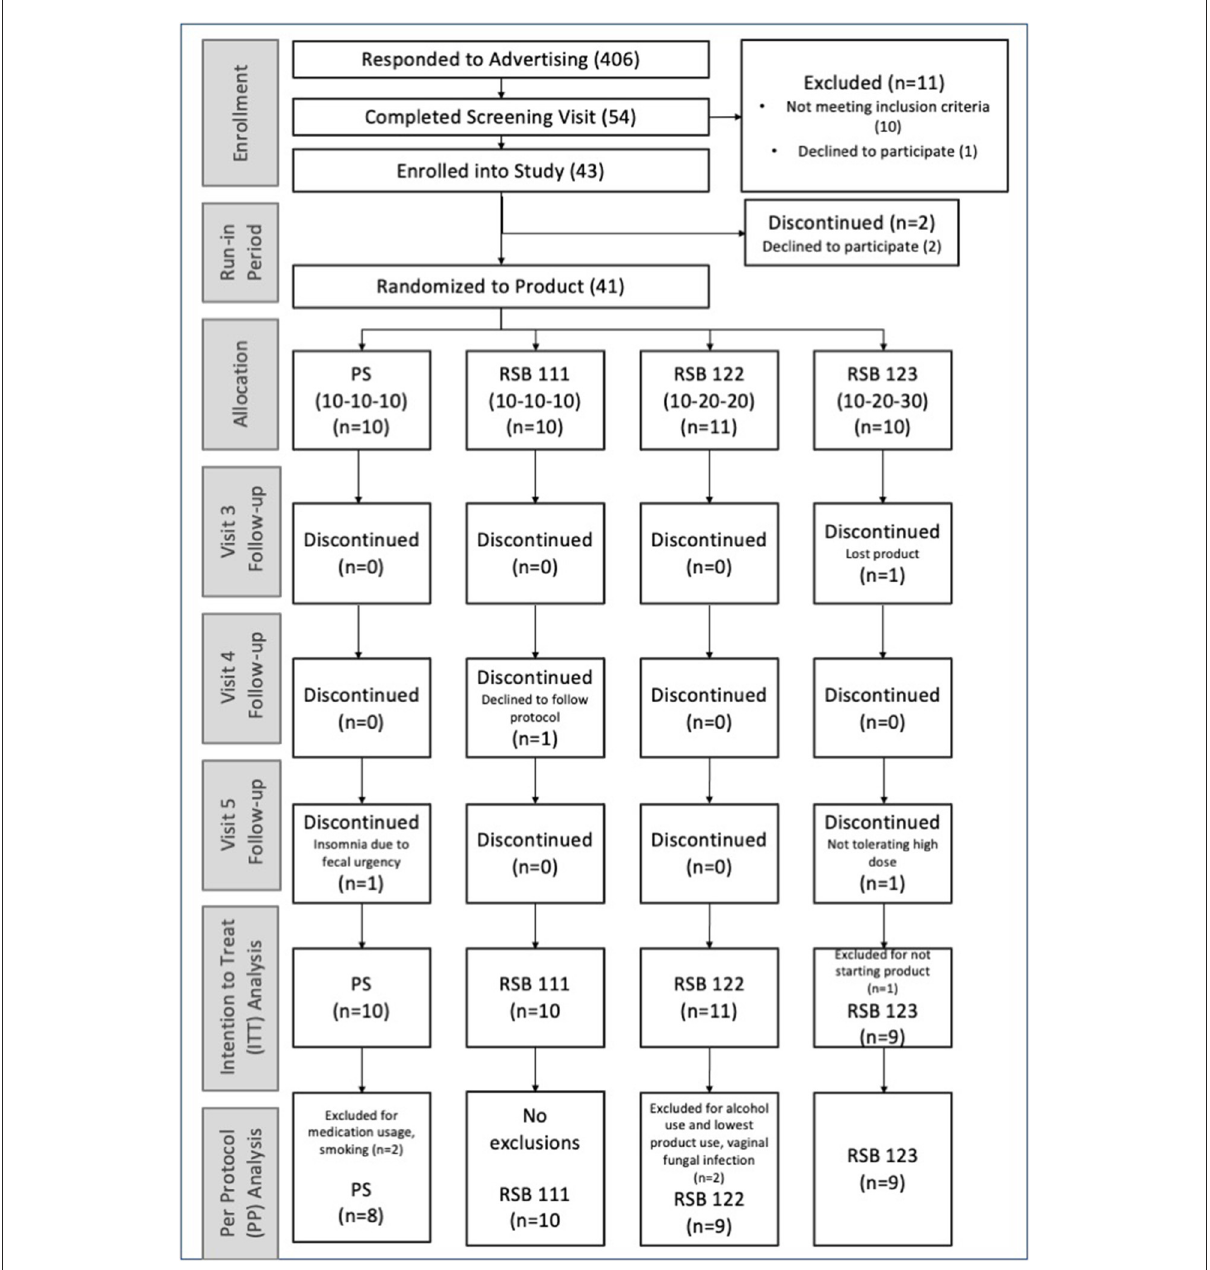
FIGURE1 Consort diagram. Enrollment of the participants and numbers per group included in the ITT and PP analyses. Randomization to product occurred at visit 2.